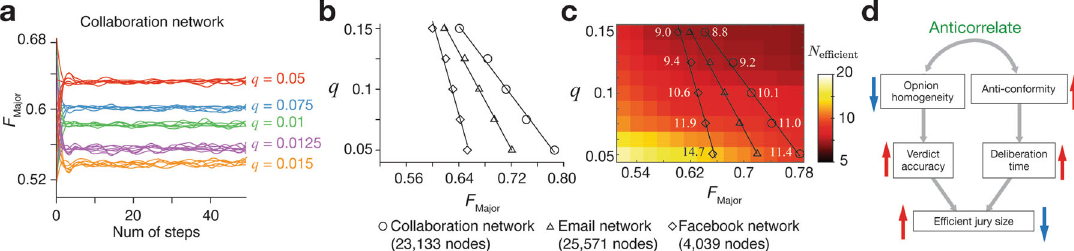
Fig. 4 Ef fi cient jury size in real-life settings. We examined associations between the opinion homogeneity F Major and anti-conformity tendency q in the three real-life large-scale social networks (Leskovec and Sosic, 2016). In all the three networks, F Major converged toward a q -dependent speci fi c value even when the initial F Major was largely different ( a ). The convergence F Major was negatively correlated with q ( b ). By applying such an inverse association between F Major and q , we could narrow down N ef fi cient into 11.8±3.0 ( c ). These results imply a statistical mechanism, which avoids